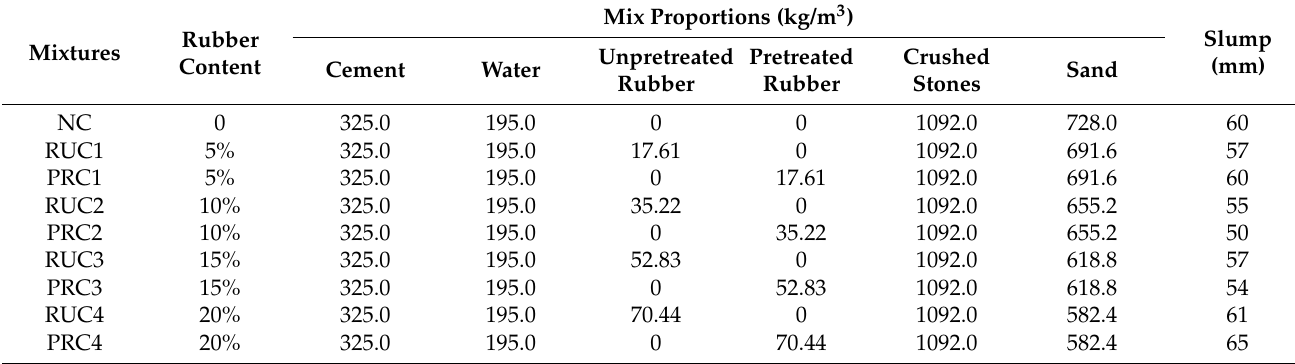
Table 2. The mix proportions and slumps of